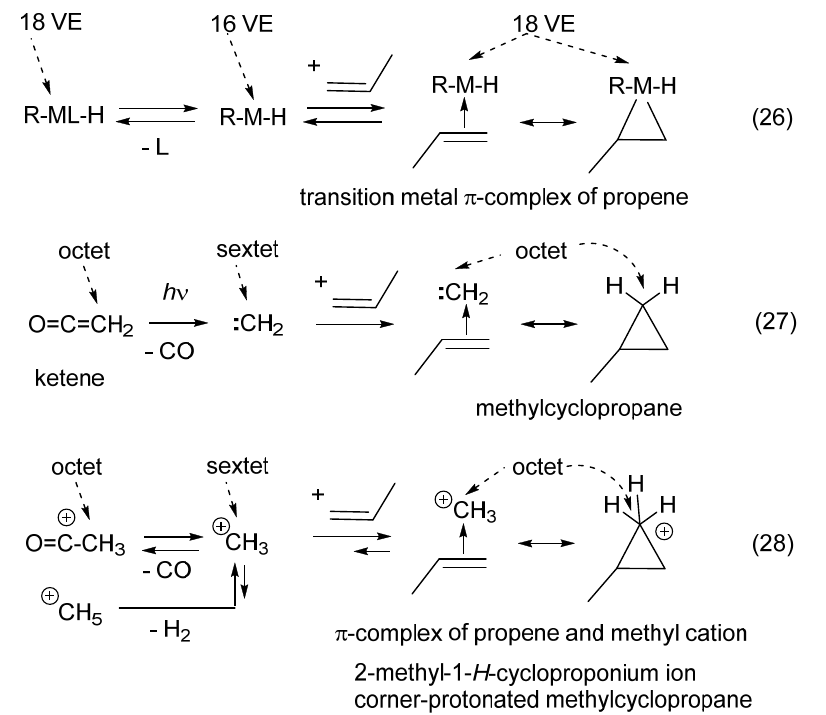
Table 1. Fundamental reactions of transition metal complexes and comparison with organic reactions. Tolman’s rules are applied to define (conventionally) the oxidation number x of the metal, M (VE: number of valence electrons). [M] = M (x) for a metal bearing other ligands eventually, including solvent molecules. Reprinted with permission from Ref. [17]. Copyright 2019